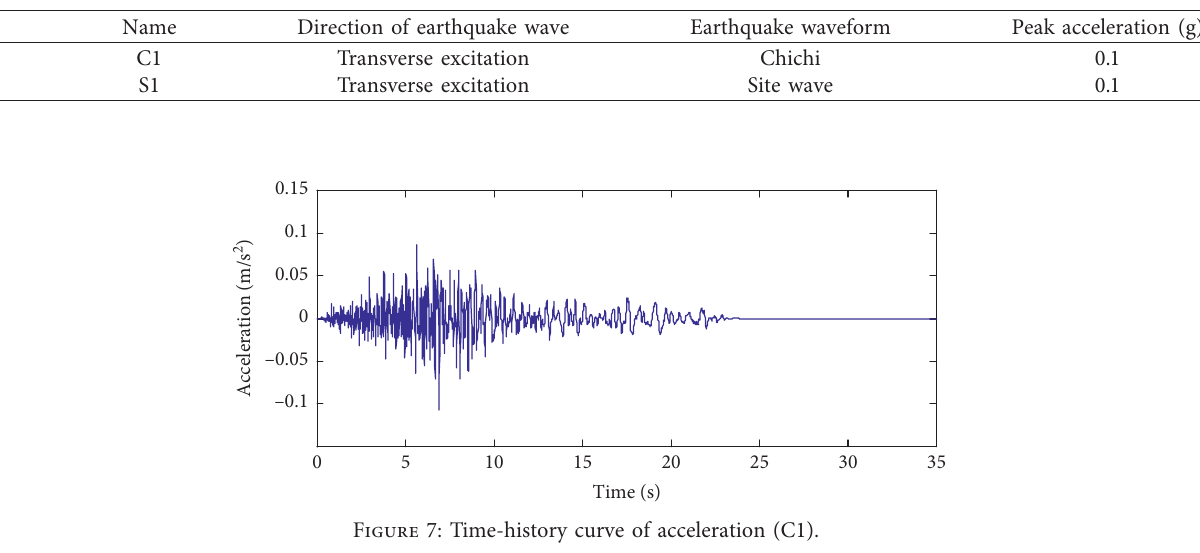
Figure 6: Arrangement of acceleration sensors (unit: cm). Table 1: Working conditions of test table.